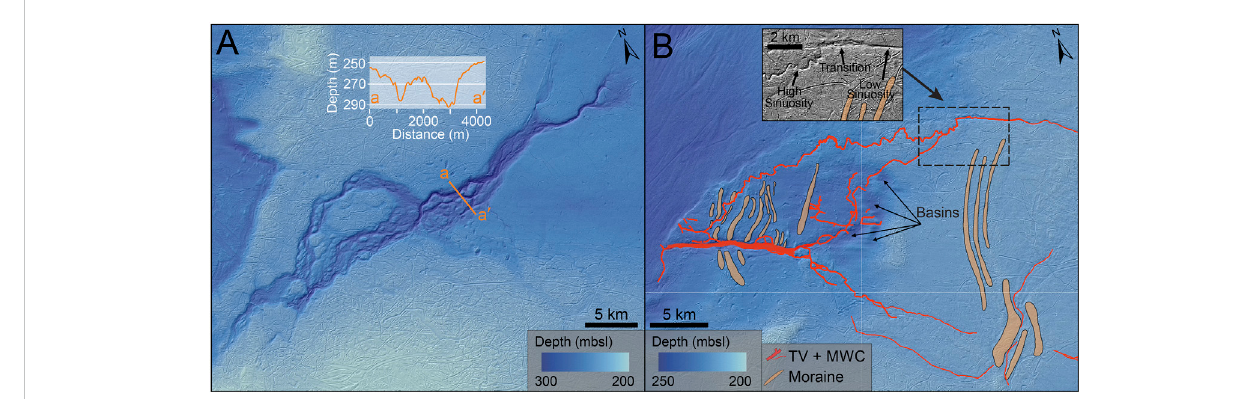
FIGURE 8 (A) AbraidedtunnelvalleyterminatingtothewestinSentralbankrenna(Bjarnadóttiretal.(2017) (B) Interlinkedbasins,downstreamtunnelvalley,and moraineridges, fi rstdescribedbyBjarnadóttiretal.(2017).MoraineridgesandmeltwaterchannelmappinginBisadaptedfrompreviouslypublishedwork (Esteves et al., 2017; Newton and Huuse, 2017).